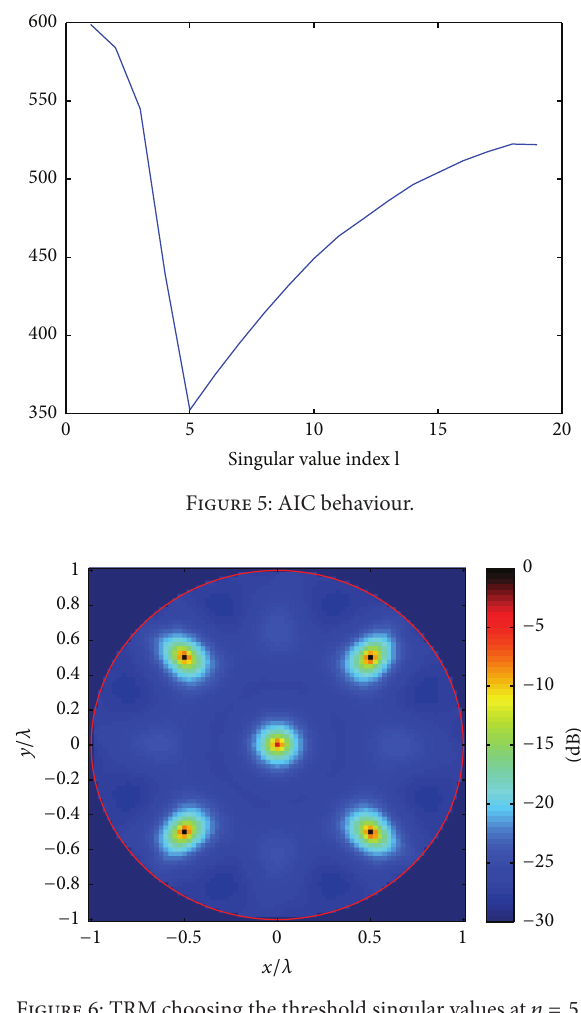
Figure 6: TRM choosing the threshold singular values at 𝑛 = 5